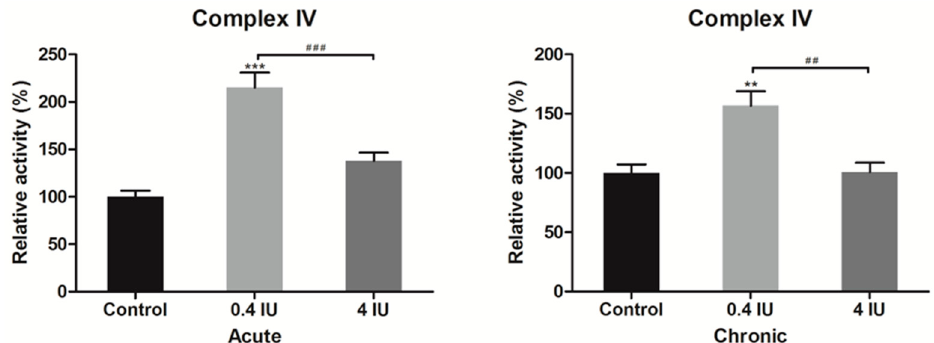
Figure 7. Relative complex IV activity following acute and chronic insulin treatment. Data showing complex IV activity, expressed relative to a control (taken as 100%), represent the means ± SEM values of three independent experiments. * compared to control: ** p ≤ 0.01, *** p ≤ 0.001; # 0.4 IU vs. 4 IU: ## p ≤ 0.01, ### p ≤ 0.001.